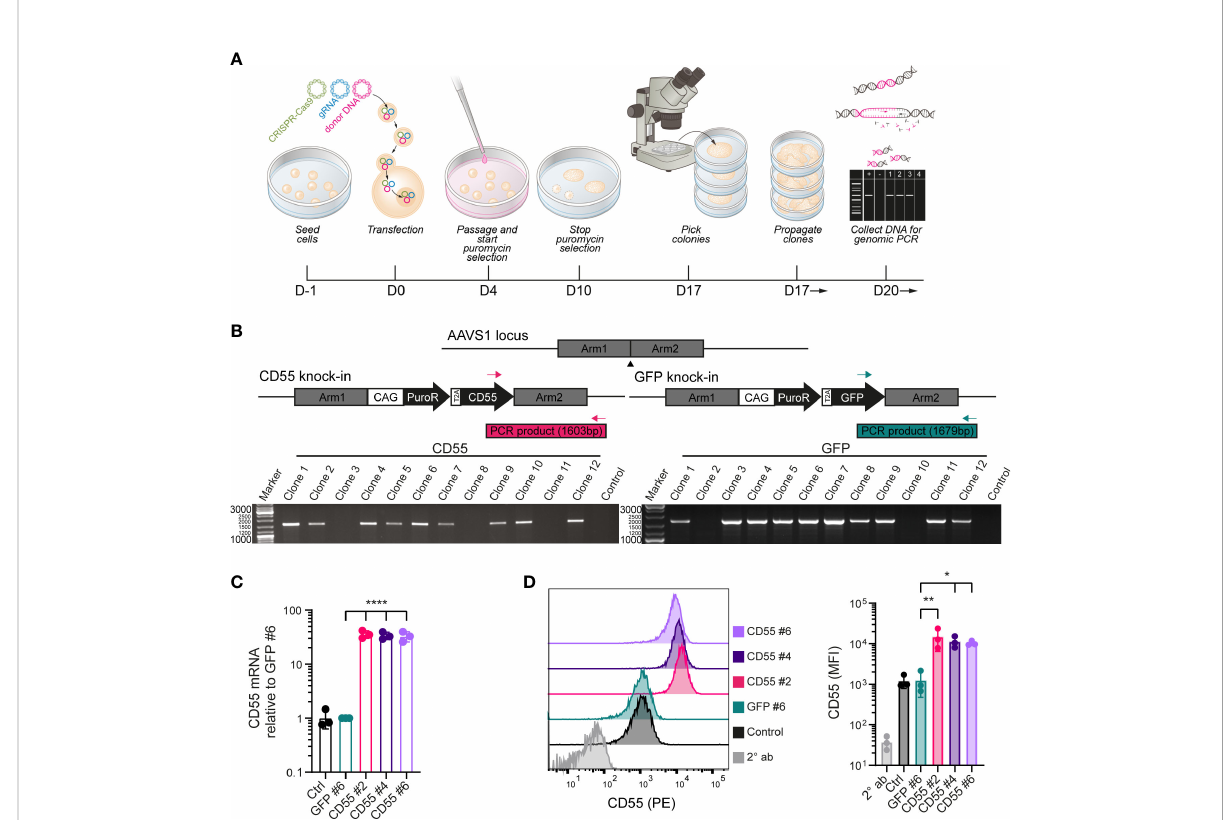
FIGURE 2 Genetic modi fi cation of iPSCs to induce over-expression of CD55. (A) Schematic of the genetic modi fi cation strategy by transfection of plasmids in iPSCs using lipofectamine and puromycin selection. (B) PCR strategy with inserted sequences for CD55 or GFP and a puromycin resistance (puroR) gene in the AAVS1 locus and analysis of puromycin selected iPSC clones with 2 distinct primer sets. DNA of the parental unmodi fi ed cell line was used as a negative control and clones were screened for the ampli fi cation of a PCR product with the indicated size (1603bp for CD55 insert or 1679bp for GFP insert). (C) mRNA expression of CD55 in control iPSCs and modi fi ed iPSC clones (GFP #6, CD55 #2, 4 and 6) measured by RT-qPCR (n=3). (D) CD55 protein expression in control iPSCs and modi fi ed iPSC clones measured by fl ow cytometry (n=3) showing a representative histogram. Staining with only PE-conjugated secondary antibody (2° ab) is shown in light grey. Error bars show standard deviation and signi fi cance (*p < 0.05; **p < 0.01; ****p < 0.0001) was evaluated using one-way ANOVA comparing each sample to iPSC-GFP with Dunnett correction for multiple